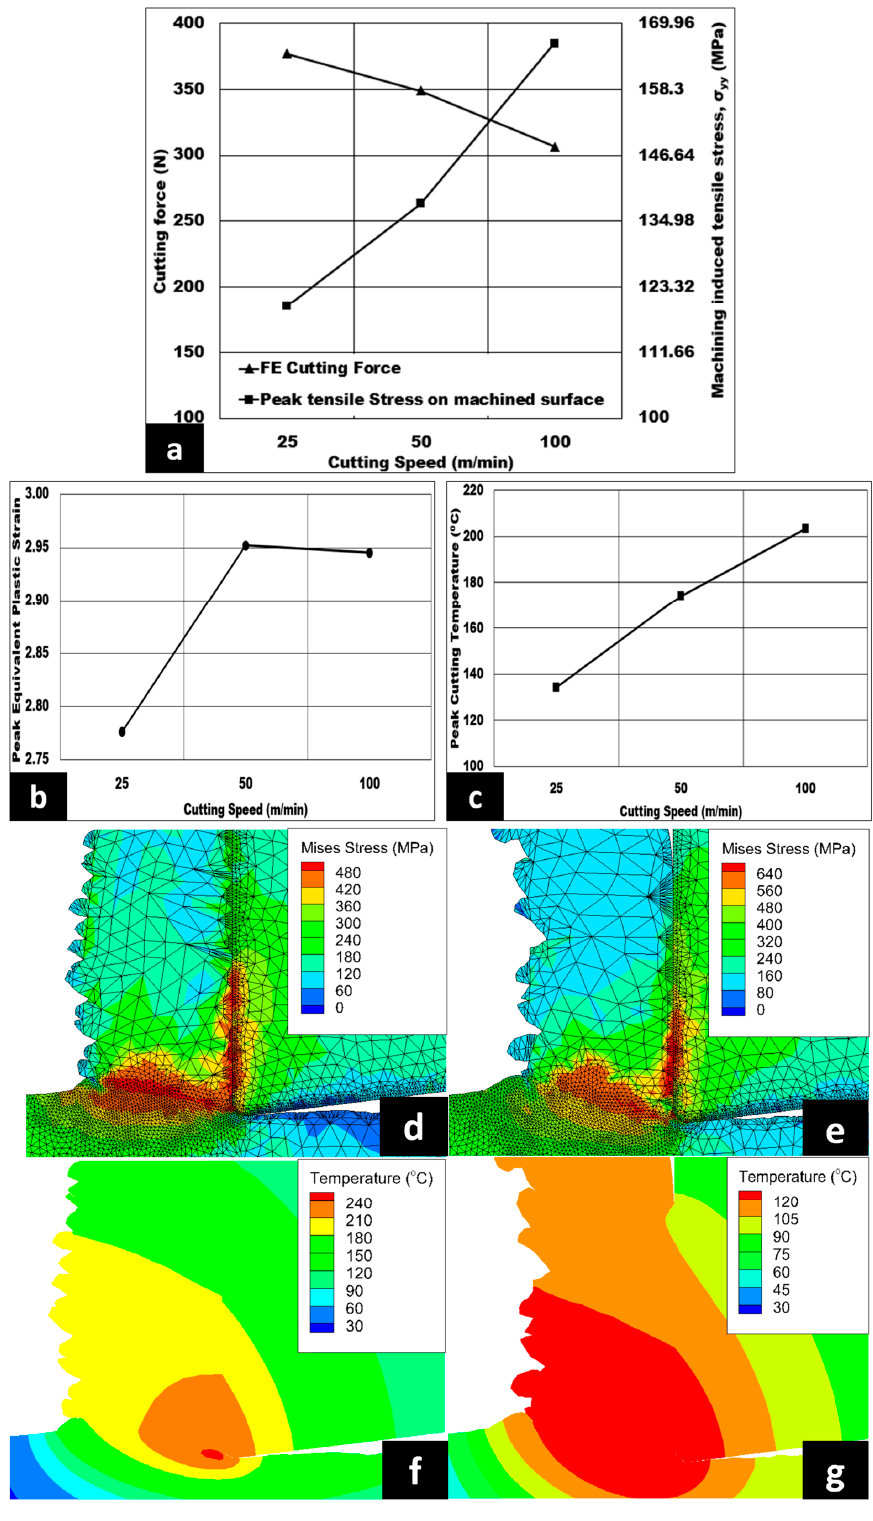
Figure 4. ( a – c ) Variation of cutting velocity on cutting forces, machining induced stress on machined surface, peak equivalent plastic strain, and peak cutting temperature (AdvantEdge TM simulation) under dry conditions. 7075/hollow alumina shell syntactic foams (vol% = 10%, h = 0.07 mm, b = 3 mm, Dry cut); Von Mises stress contour at ( d ) 100 m/min and ( e ) 25 m/min; peak cutting temperature contour at ( f ) 100 m/min and ( g ) 25